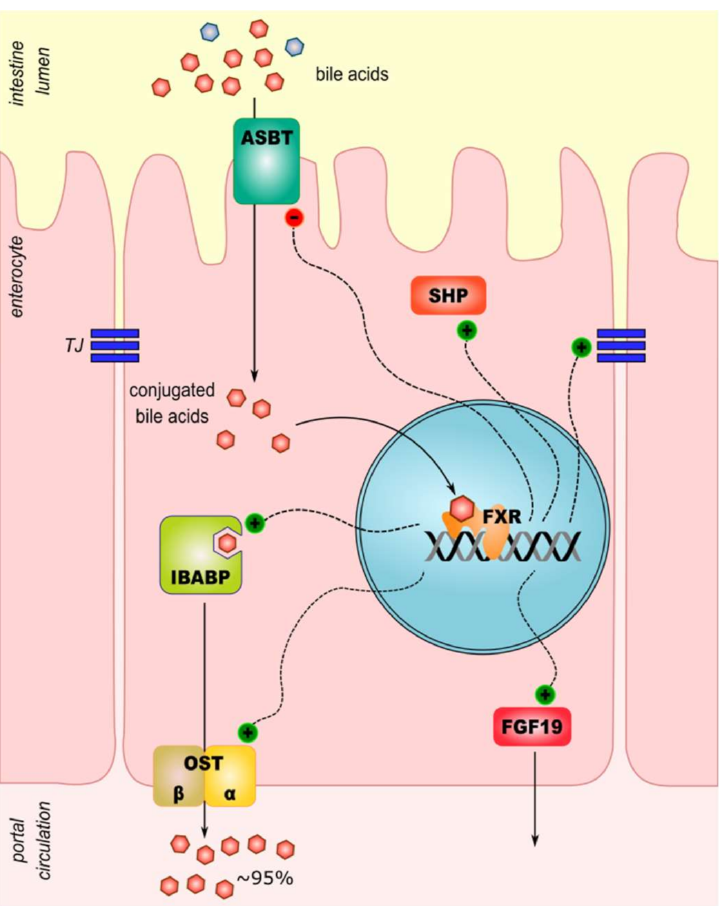
Figure 1. A model of intestinal cellular transport and signaling of bile acids. A majority of conjugated bile acids is reabsorbed by the intestinal epithelial cells. Unconjugated bile acids escape uptake through ASBT and enter the colon where they undergo further metabolism by local microbiota to generate secondary bile acids. ASBT, sodium-dependent bile acid transporter; FGF19, fibroblast growth factor 19; FXR, farnesoid X receptor; IBABP, ileal bile acid-binding protein; OST α / β , organic solute transporter α / β ; SHP, small heterodimer